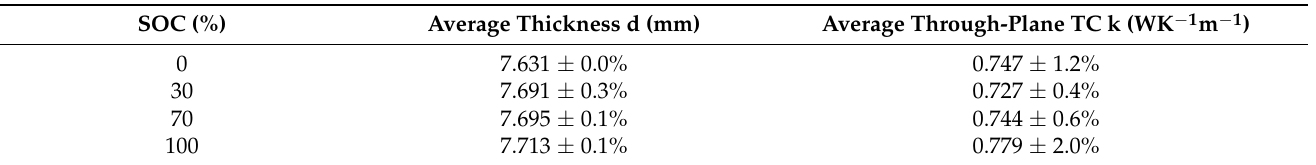
Table 1. Results for the average cell thickness and average through-plane thermal conductivity for fresh cells in dependence with SOC.